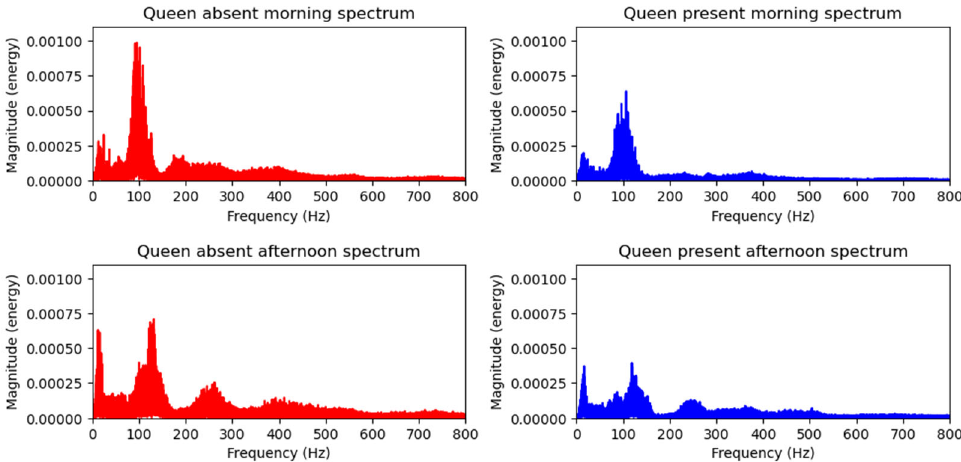
Figure 10. Acoustic Spectra for Queen Absent (red, left ) and Queen Present (blue, right ) hives. The upper graphs show data recorded in the morning, between 1 am and 2 am, whilst the lower ones display afternoon data recorded between 1 pm and 2